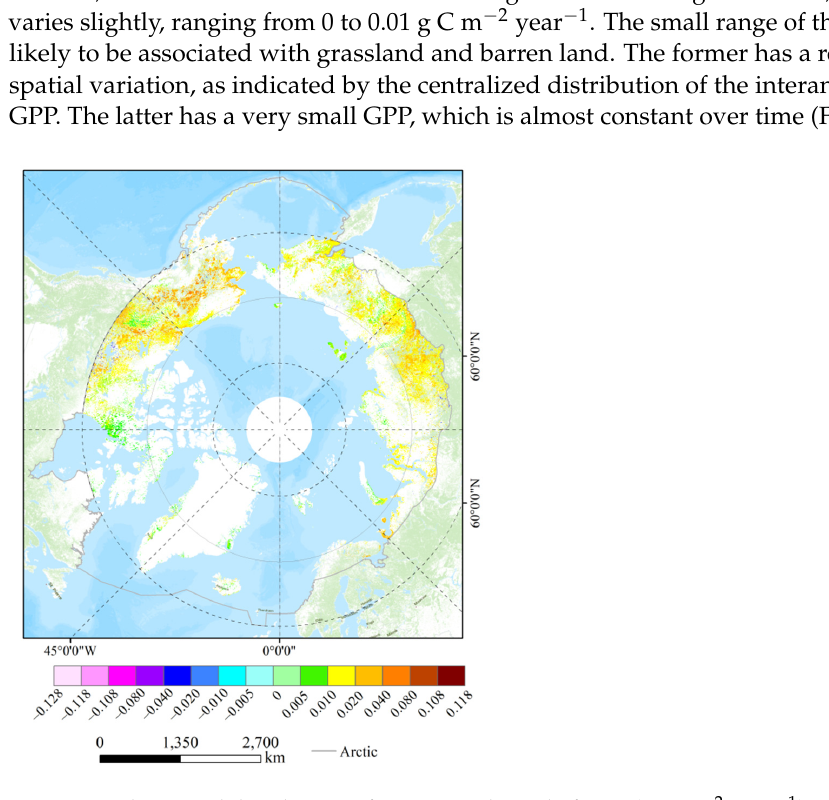
Figure 14. The spatial distribution of interannual trend of GPP (g C m − 2 year − 1 ) over the Arctic (at 97.5% confidence level based on MK test).